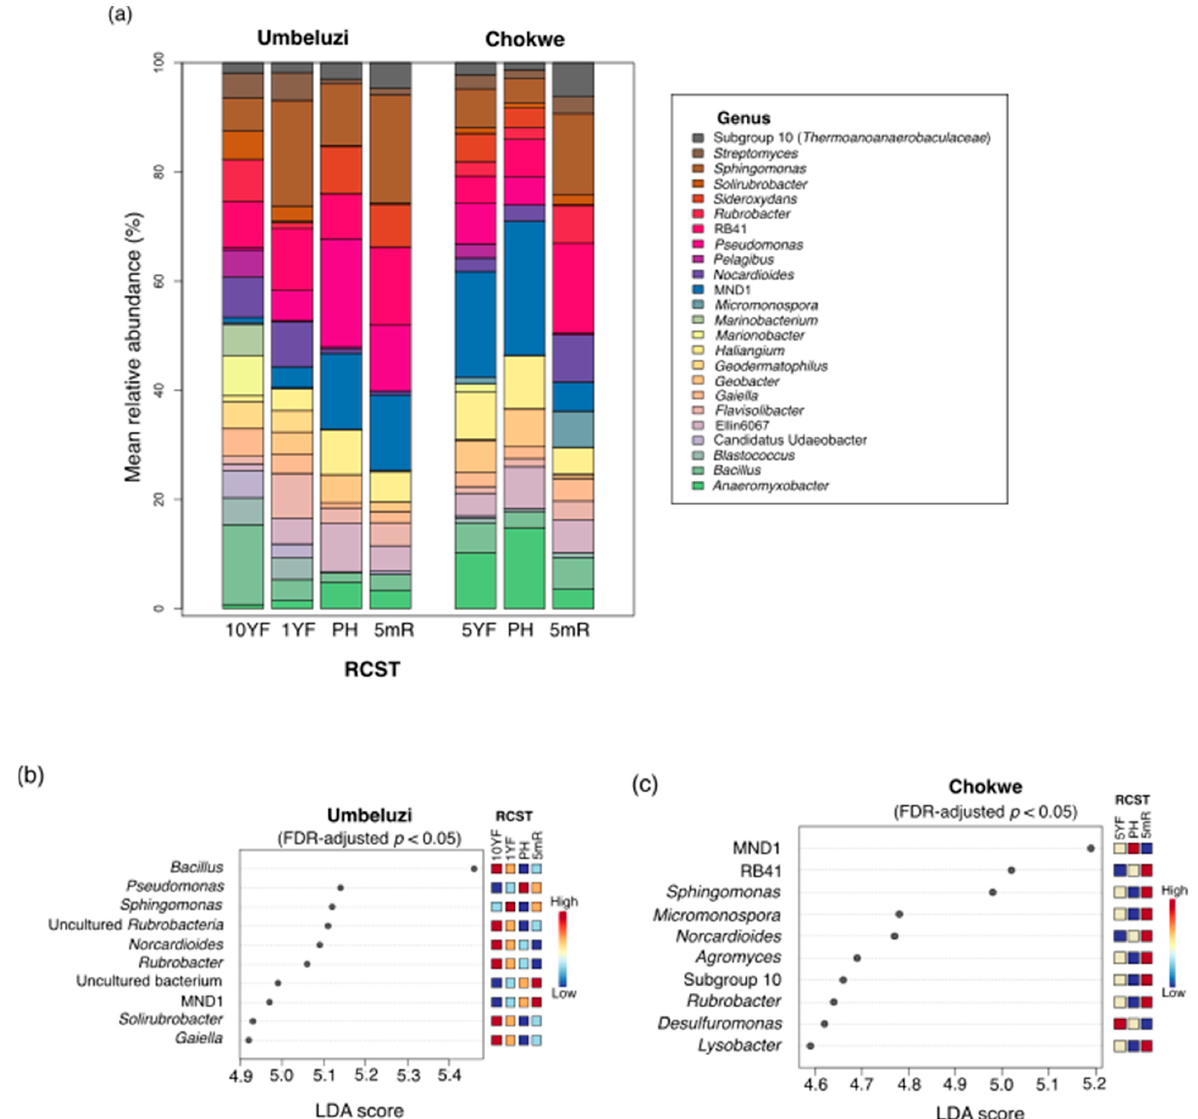
Figure 5. Relative abundance and differentially abundant phylotypes at the genus taxonomic rank. ( a ) Mean relative abundance. ( b ) Top 10 differentially abundant phylotypes (FDR-adjusted p < 0.05, LDA > 4.0) in Umbeluzi. ( c ) Top 10 differentially abundant phylotypes (FDR-adjusted p < 0.05, LDA > 4.0) in Chokwe. In Figure 4a, phylotypes with relative proportion less than 0.01 (1%) and phylotypes unclassified at the genus taxonomic level were excluded. Family names are in parenthesis for some phylotypes without standard genus names. See Tables S2 and S3 for other differentially abundant phylotypes. 10YF, ten years fallow; 5YF, five years fallow; 1YF, one year fallow; PH, postharvest; 5mR, five months postharvest recovery or